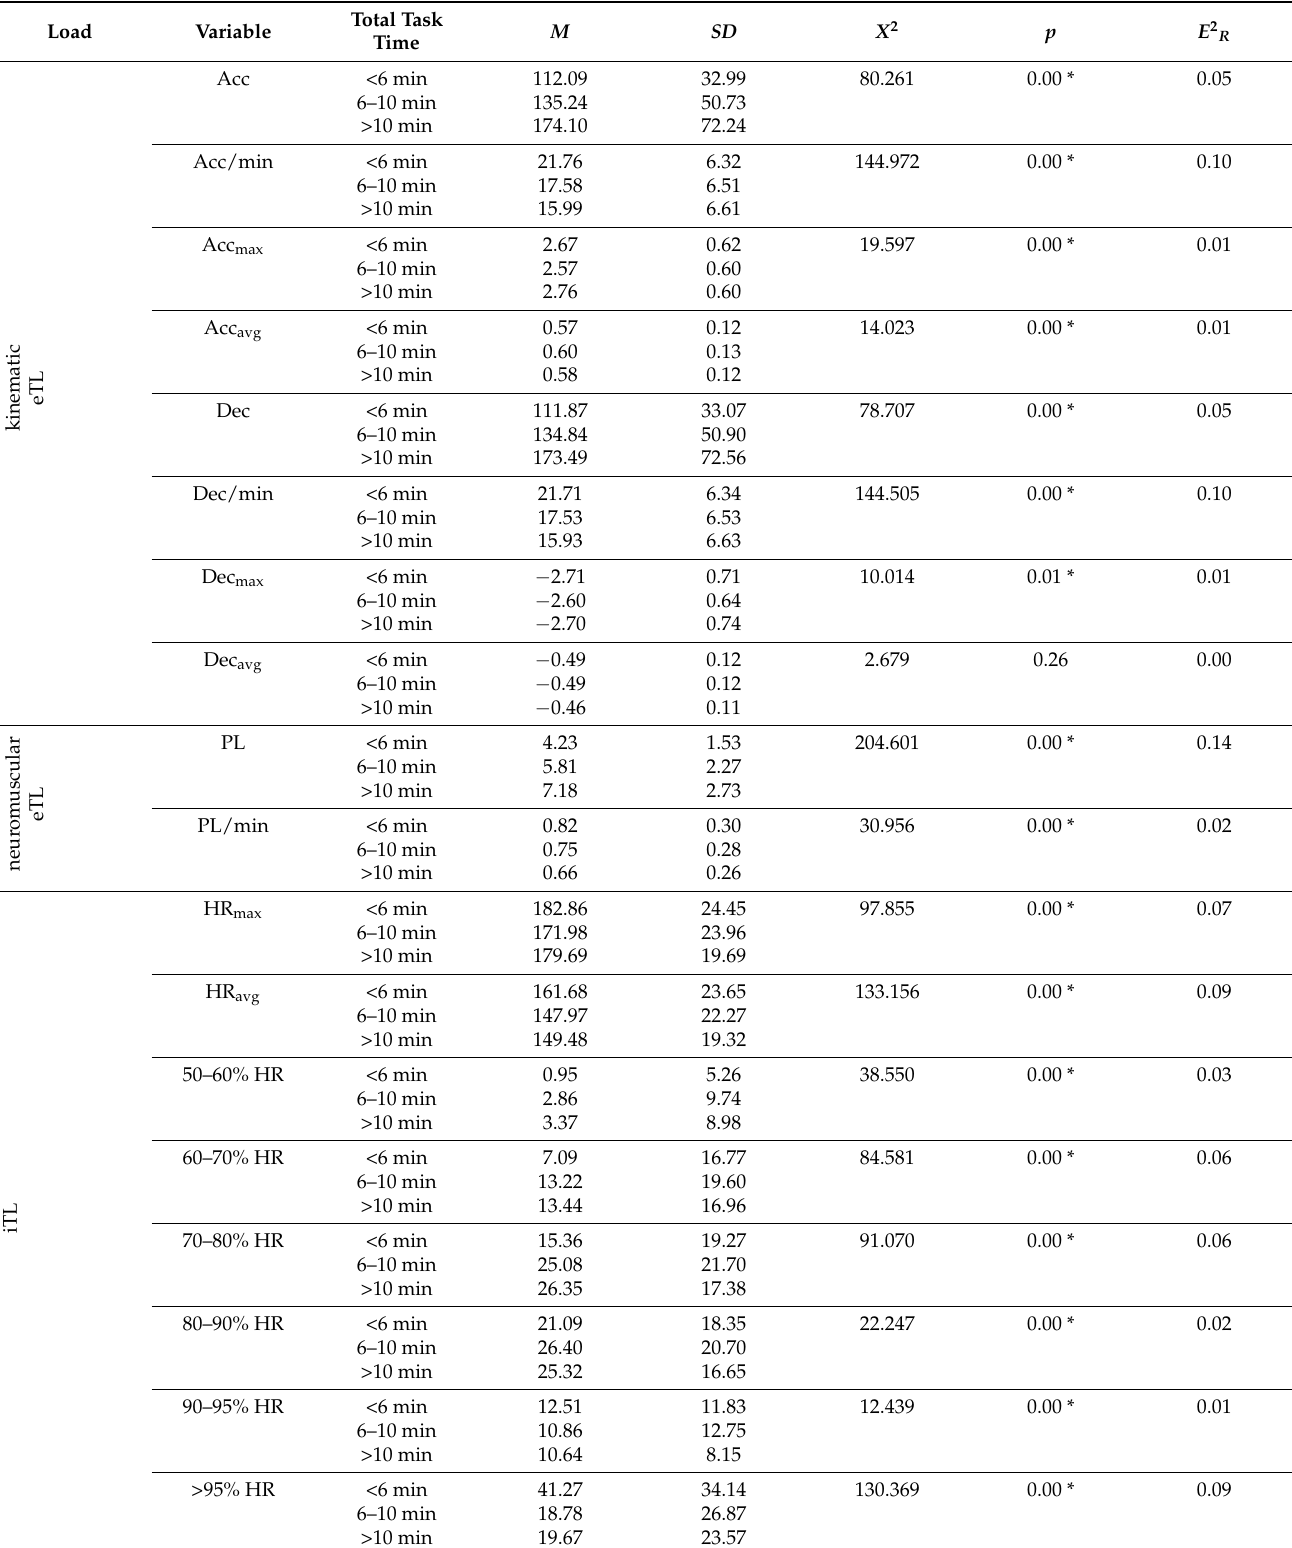
Table 3. Inferential results of the variables studied independently according to the total task